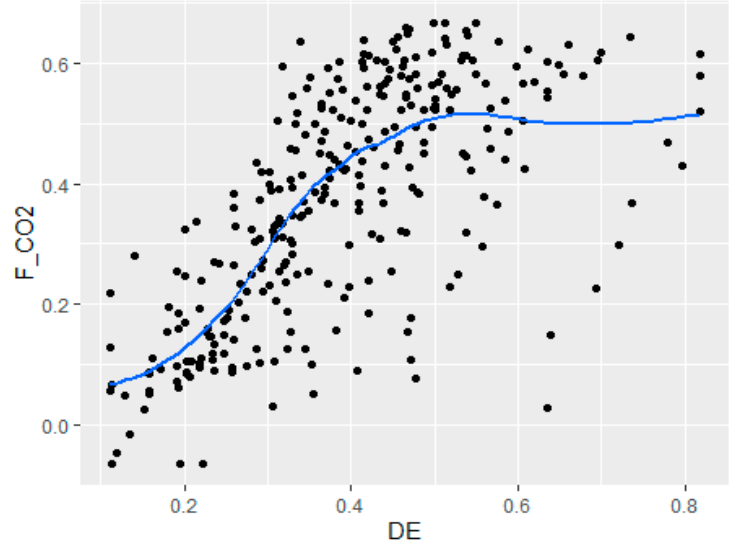
Figure 1. Digital economy and F CO2 .